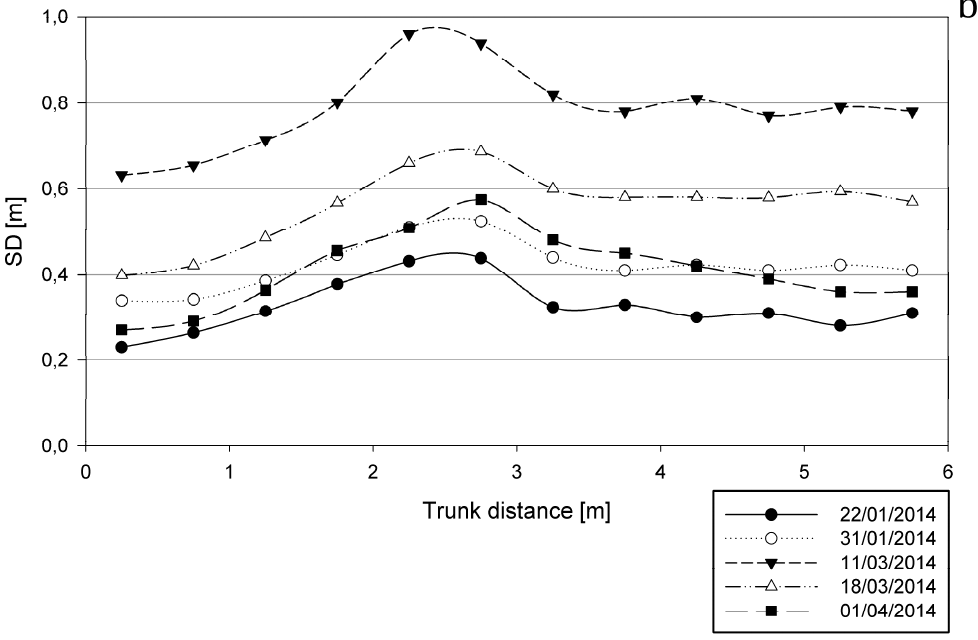
Figure 7. Average snow depths as a function of distance from the tree trunk, for PCA component